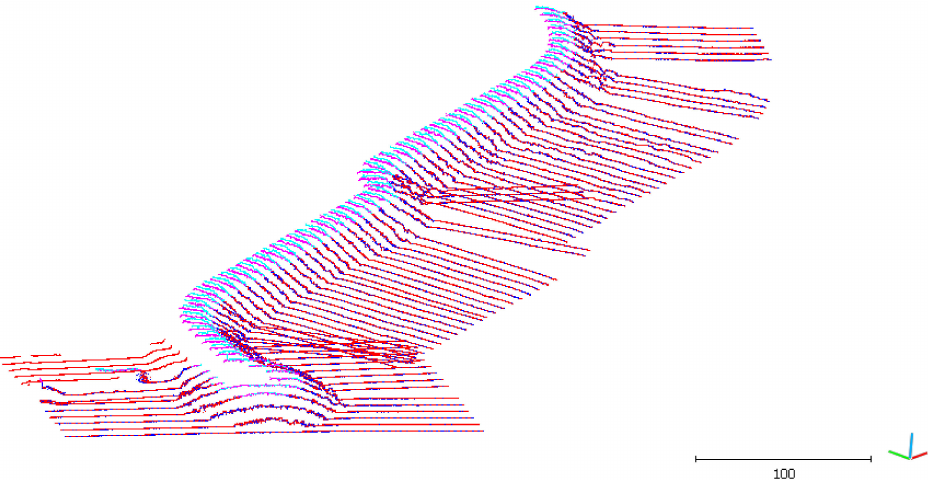
Figure 13. View of the section clouds of DSM 1 and DSM 2. The red and blue sections refer to the submerged portion of DSM 1 and 2, respectively, whereas the magenta and cyan sections are relative to the emerged portion.